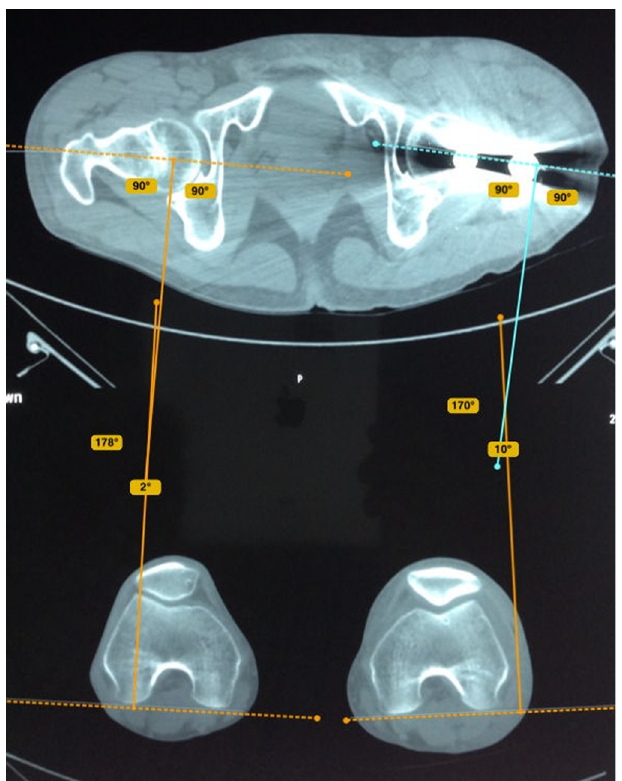
Figure 3. Measurement of anteversion angle on the fractured and healthy side by Bone Ninja application; a difference between both angles is expressed as rotational malalignment. On the injured left side, there is a difference in the rotation angle of 12 ° (increase in the angle means internal rotational malalignment of 10 ° (cid:3) ( (cid:3) 2 ° )=12 ° ).